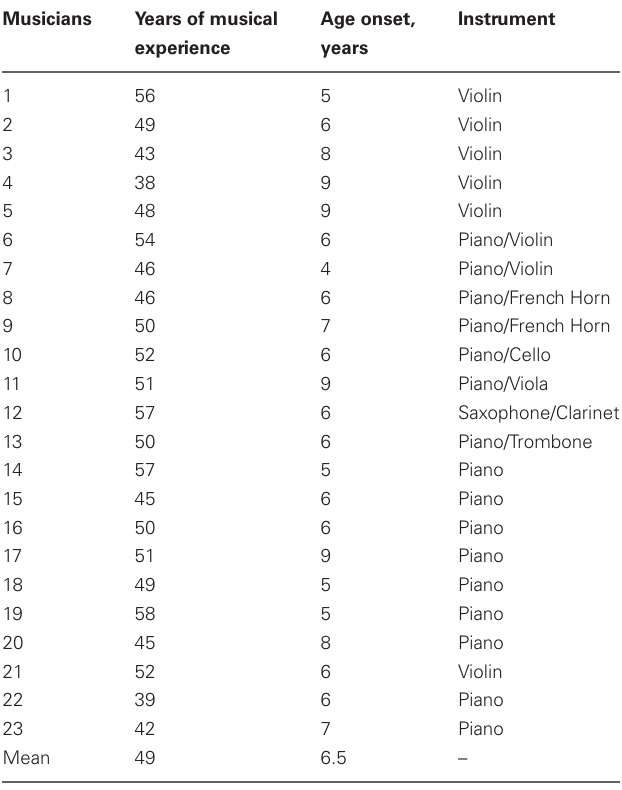
Table 1 | Participants’ musical practice